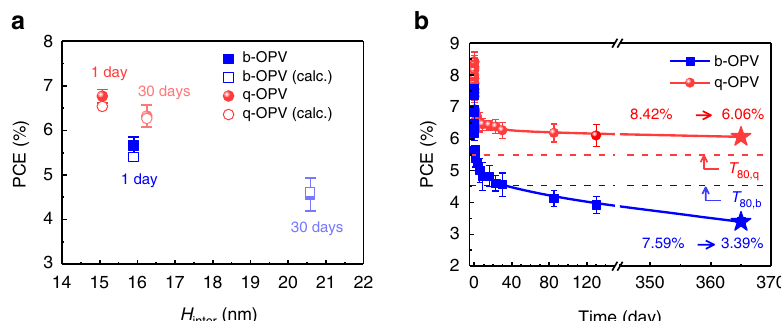
Figure 7 | Long-term durability. ( a ) Time-dependent PCE– H inter characteristics of b- and q-OPVs. The calculated PCE values were derived from the time-dependent H inter by using the modified drift-diffusion equation together with the Poisson equation. ( b ) Long-term PCE decay of b- and q-OPVs at 65 (cid:2) C. The PCEs after one year (marked with star) are theoretically predicted values based on the PCE decay as a function of H inter kinetics. The horizontal dashed lines indicate the T 80 point (defined as the point at which the PCE has fallen to 80% of the value obtained after one day operation) 30 for the b- and q-OPVs. The combined experimental and calculated results suggested that the q-OPV after one year would display a PCE of 6.06%, retaining 72.0% of its initial value, whereas the b-OPV would suffer from a much more substantial PCE loss, retaining 44.7% of its initial